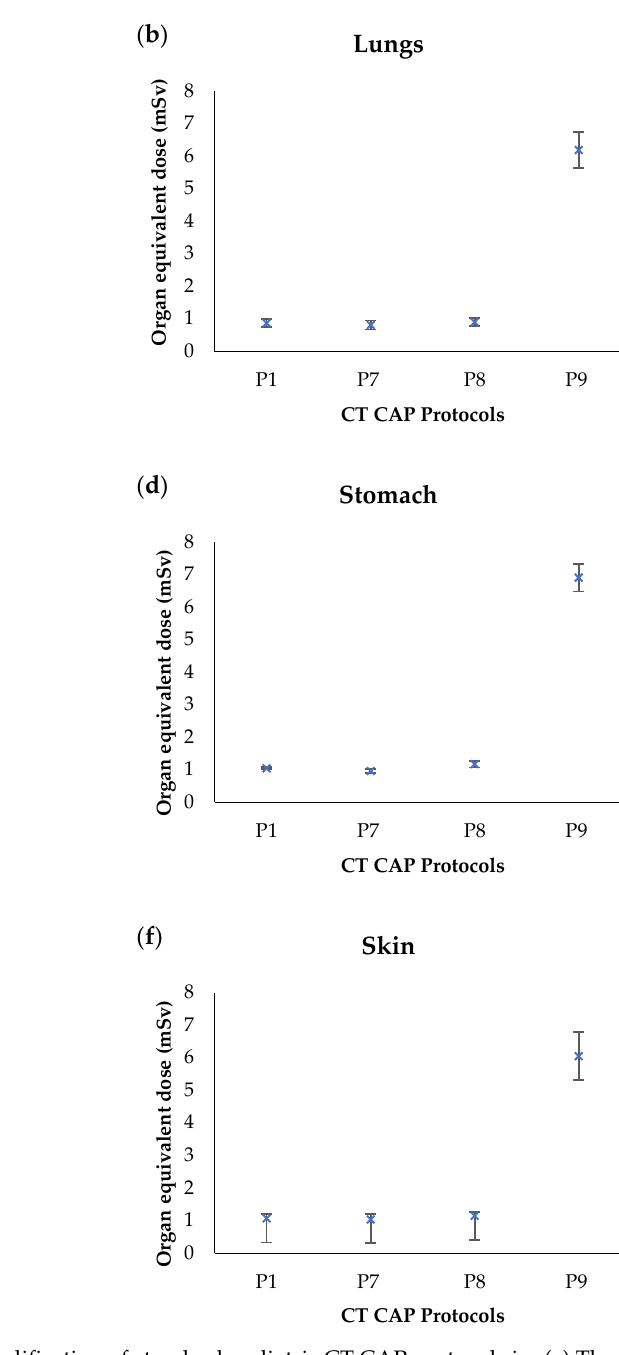
Figure 4. The mean organ-absorbed doses from the modification of standard pediatric CT CAP protocols in: ( a ) Thyroid, ( b ) lungs, ( c ) liver, ( d ) stomach, ( e ) gonads, and ( f ) skin.